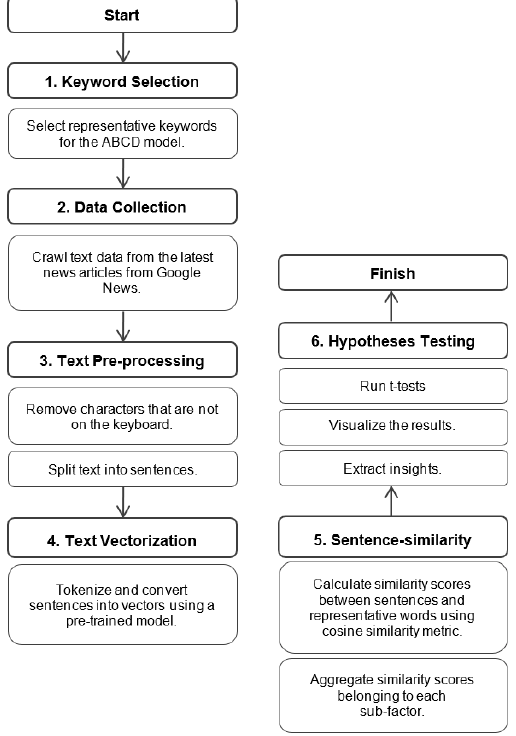
Figure 1. Workflow of overall analysis.